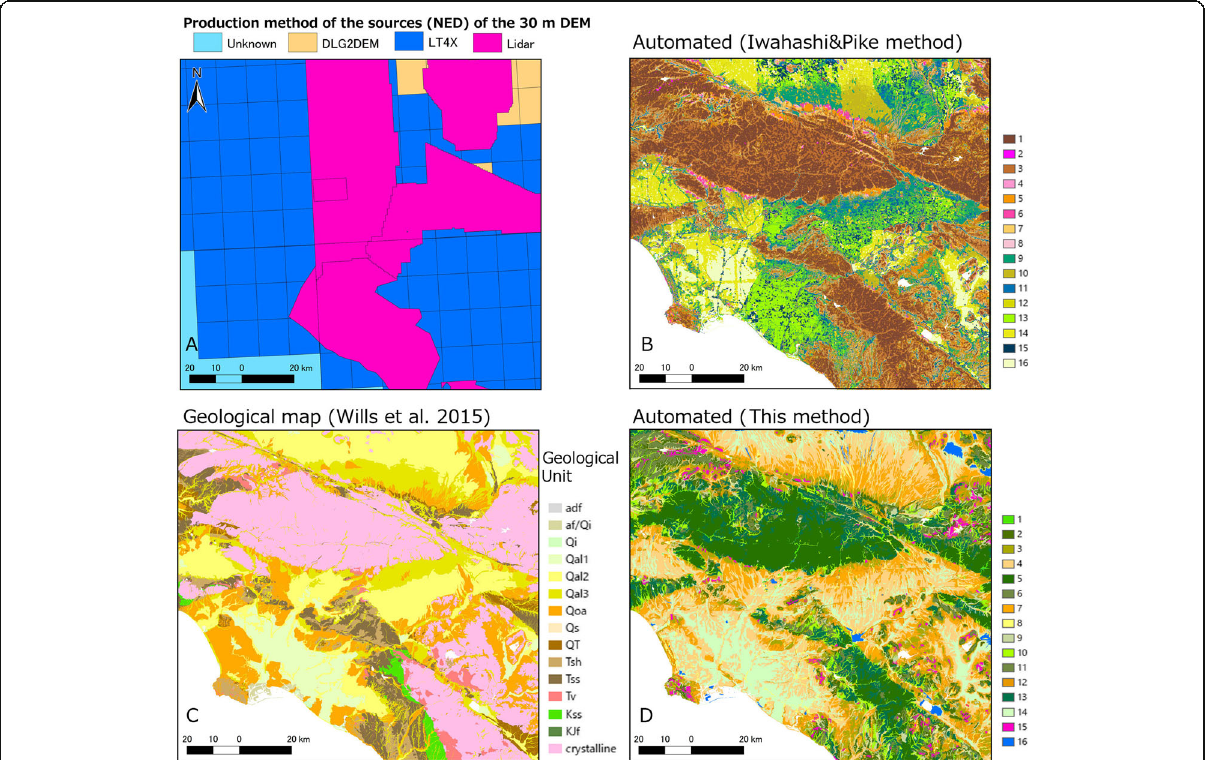
Fig. 19 Terrain classification of the Los Angeles area and related information. The location map is included in Fig. 18. a Types of the production method of the DEMs (NED). DLG2DEM: simple linear interpolation from contours; LT4X: complex linear interpolation from contours, often including hydrography; Lidar: airborne LiDAR. b Terrain classification using the method of Iwahashi and Pike (2007). c Geological map (Wills et al. 2015). d A portion of Fig.